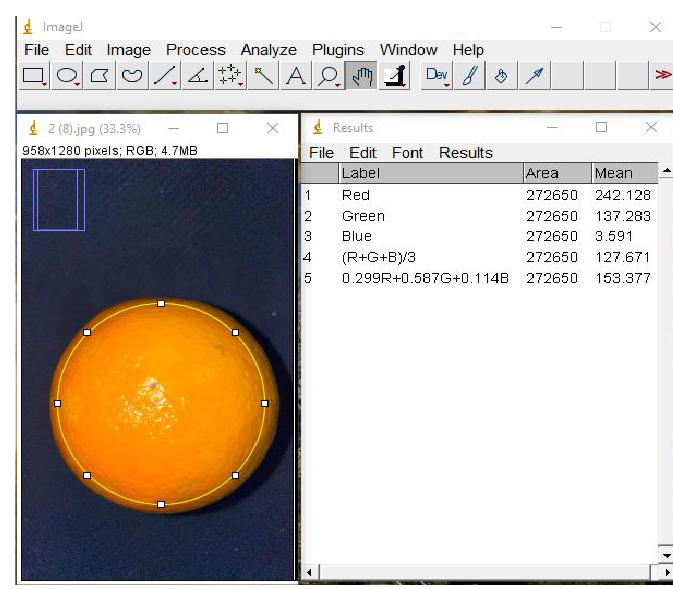
Figure 3. Measurement of RGB values using the ImageJ program.